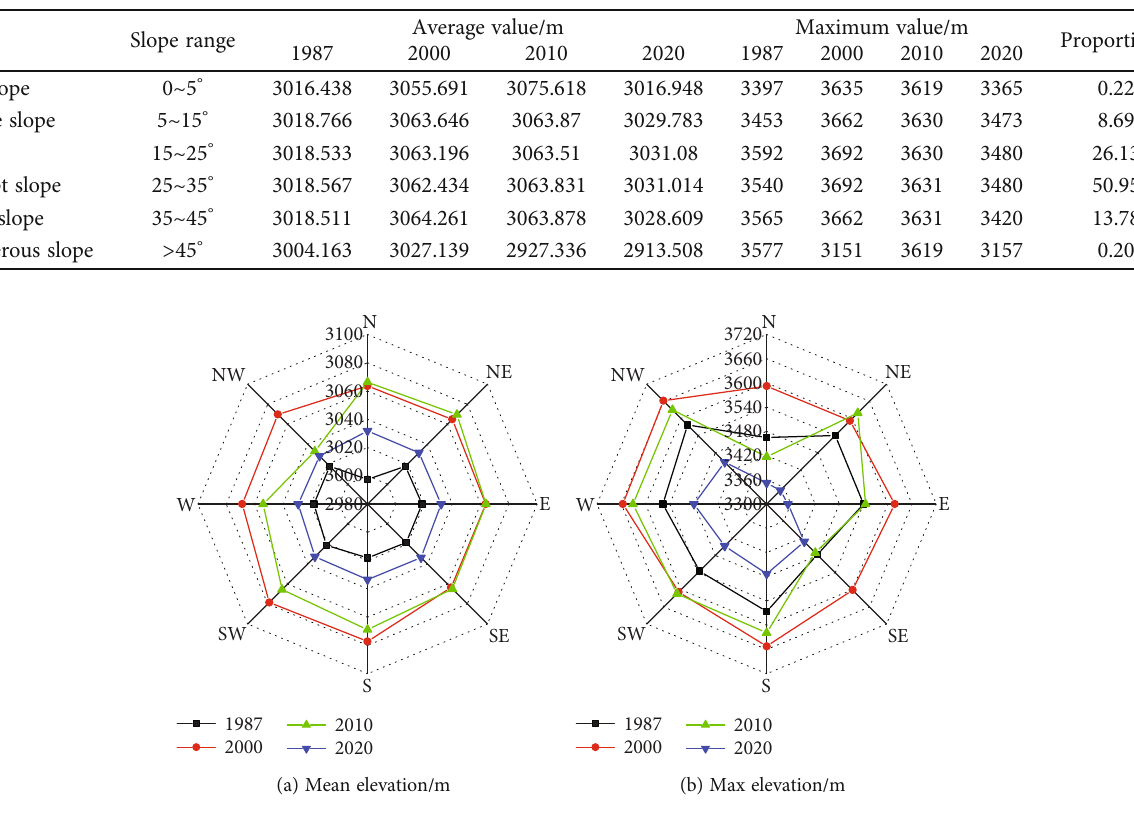
Figure 4: Treeline elevations on the slopes: (a) average value and (b) peak